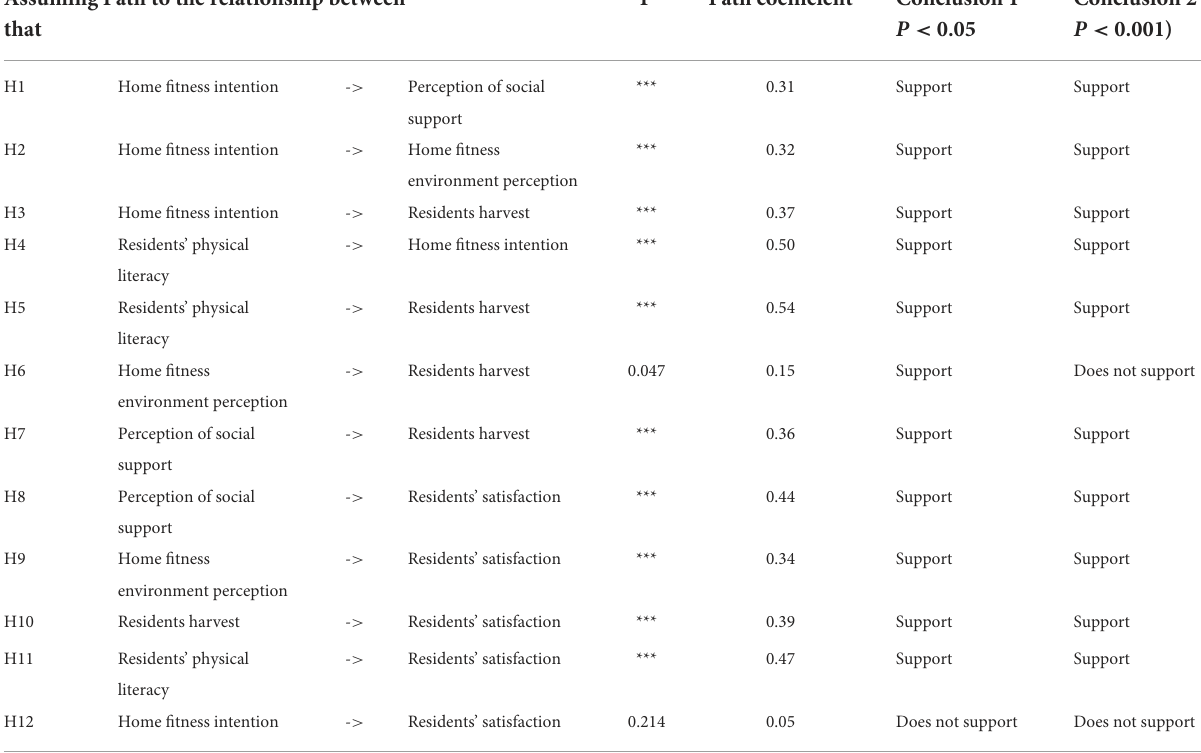
TABLE 8 Test of significance of path coefficient of structural variables of a conceptual model. Assuming